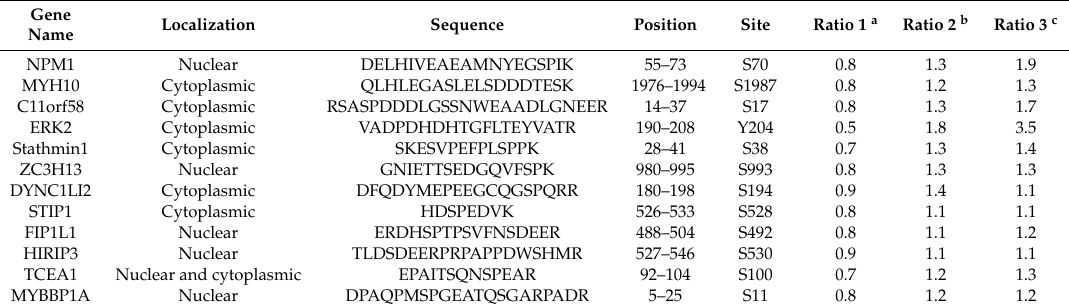
Table 1. The candidates of UHMK1 downstream phosphorylated e ff